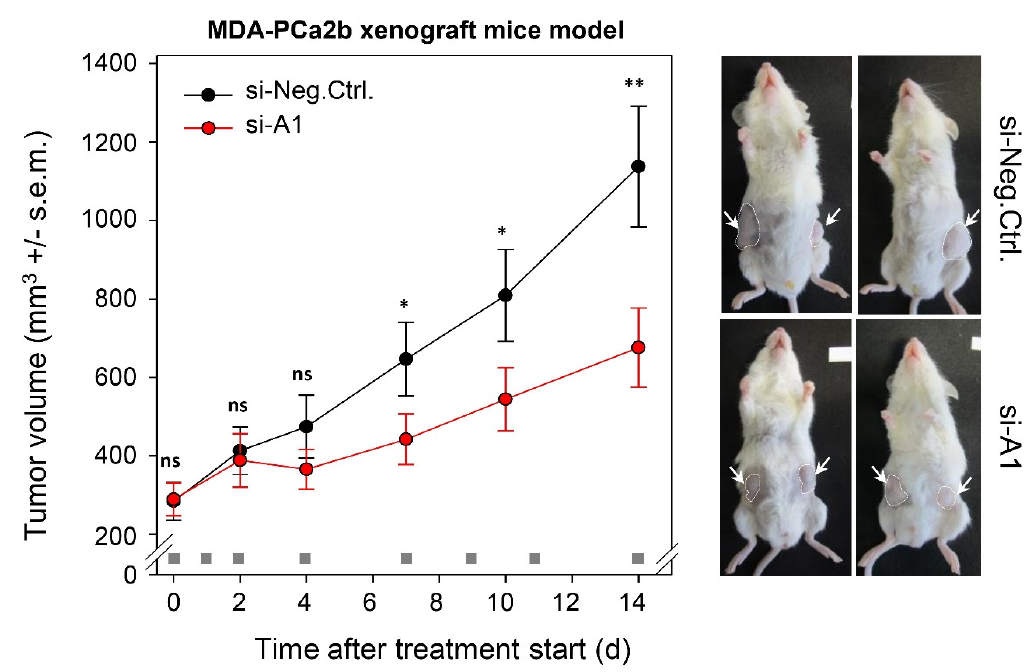
Figure 6. Treatment with nanoparticle / TAPIR-1 siRNA complexes reduces tumor growth in a PCa xenograft model in vivo. To generate PCa tumor xenografts, MDA-PCa2b cells were injected subcutaneously in 6–8-week-old immunodeficient mice (NOD / SCID / IL2r gamma (null)) after shaving the injection region. When the tumors were established after 5 weeks, mice were randomized into treatment (PEI / siA1) and control groups (PEI / siCtrl) with n = 13 tumors per group. Mice were treated at the time points indicated in the figure (gray square) using intraperitoneal injection of PEI F25-LMW / siRNA complexes (complexes containing 10 µ g siRNA; ~0.4 mg siRNA / kg body weight). Tumor volumes were measured in all three dimensions (length × width × height). After 14 d mice were sacrificed. The knockdown efficacy in vivo was 30% (RT-qPCR). Significance compared to control (si-Neg.Ctrl.): p ≤ 0.05 (*), p ≤ 0.01 (**), ns = non-significant; student-t test.